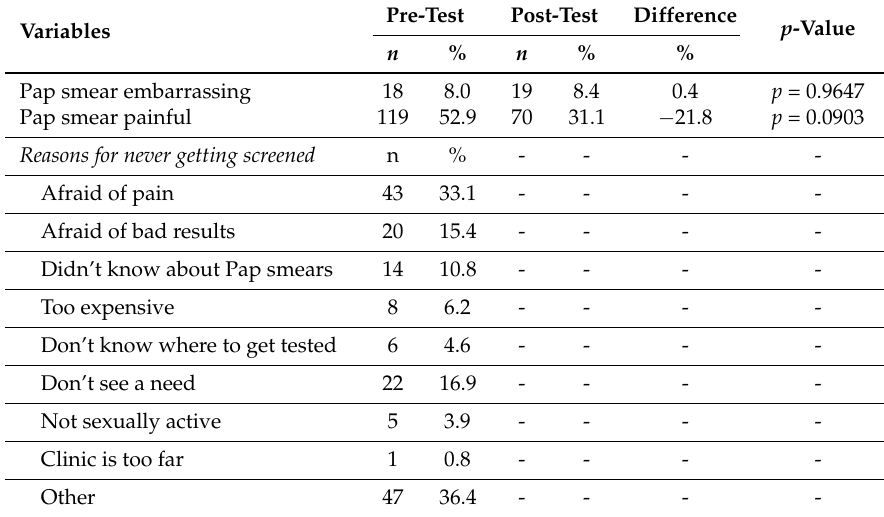
Table 3. Participant attitudes about cervical cancer